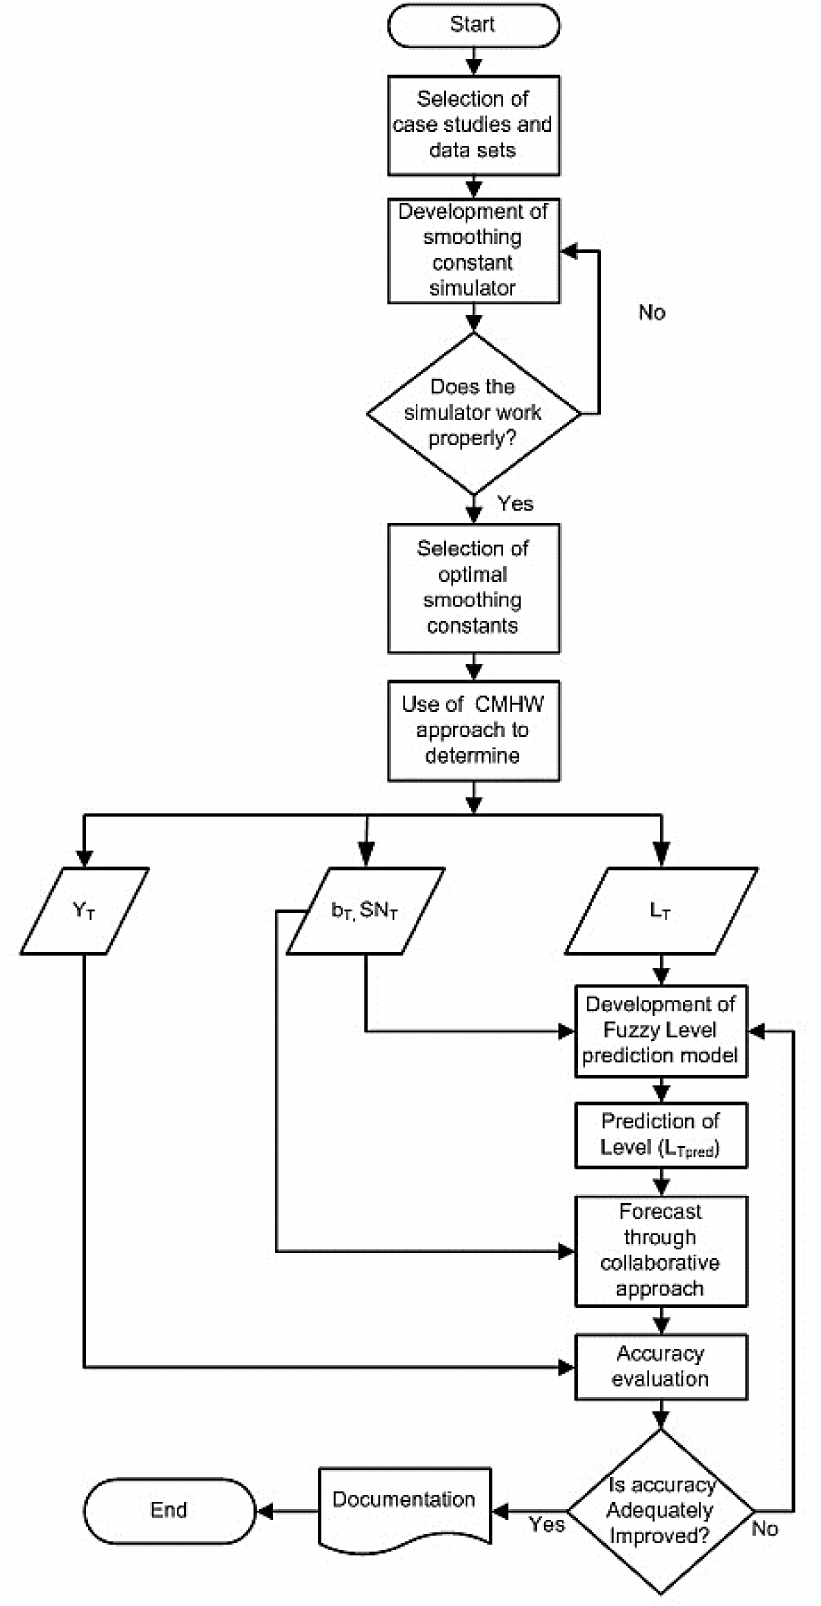
Figure 1. Flow chart for proposed collaborative multiplicative Holt-Winters (Coll-MHW) forecasting